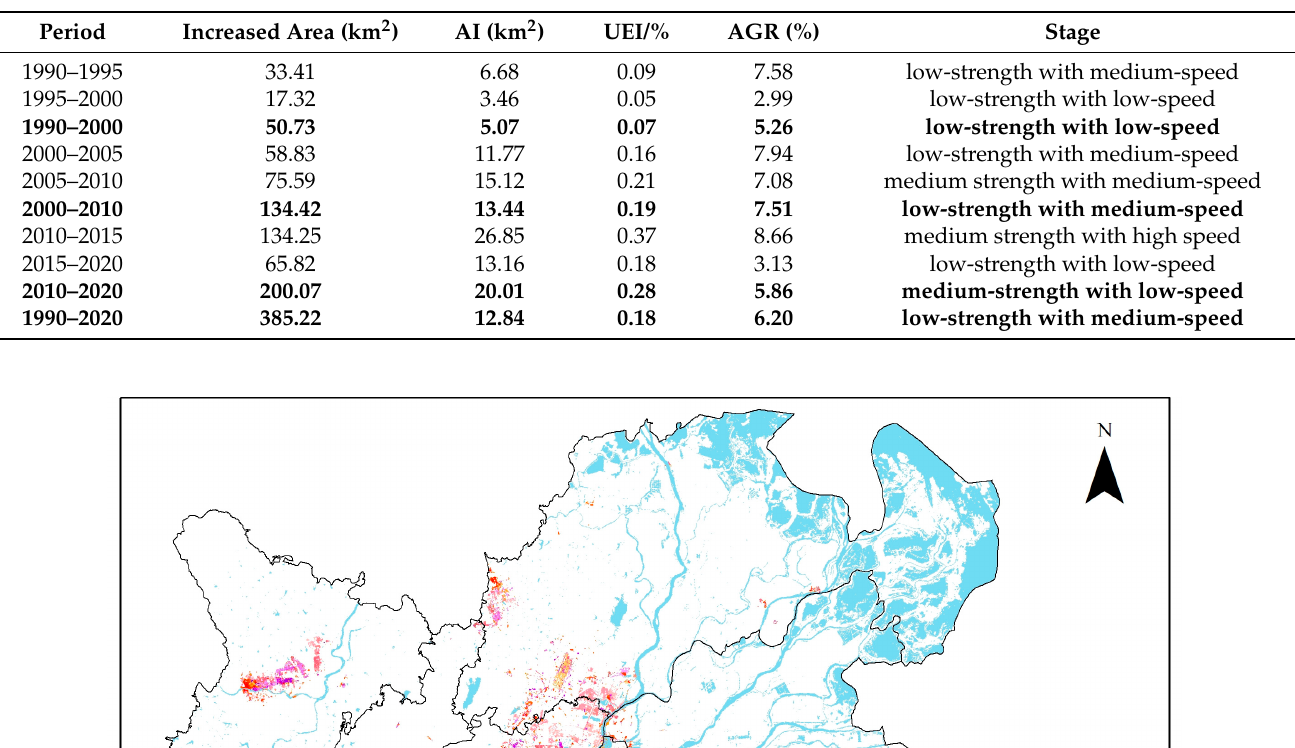
Table 2. Statistical table of urban construction land area change in Nanchang city from 1990 to 2020.